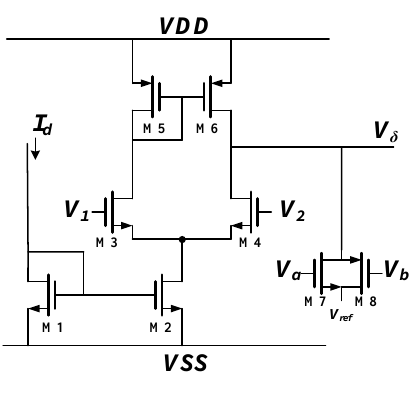
Figure 7. Schematic of Delta